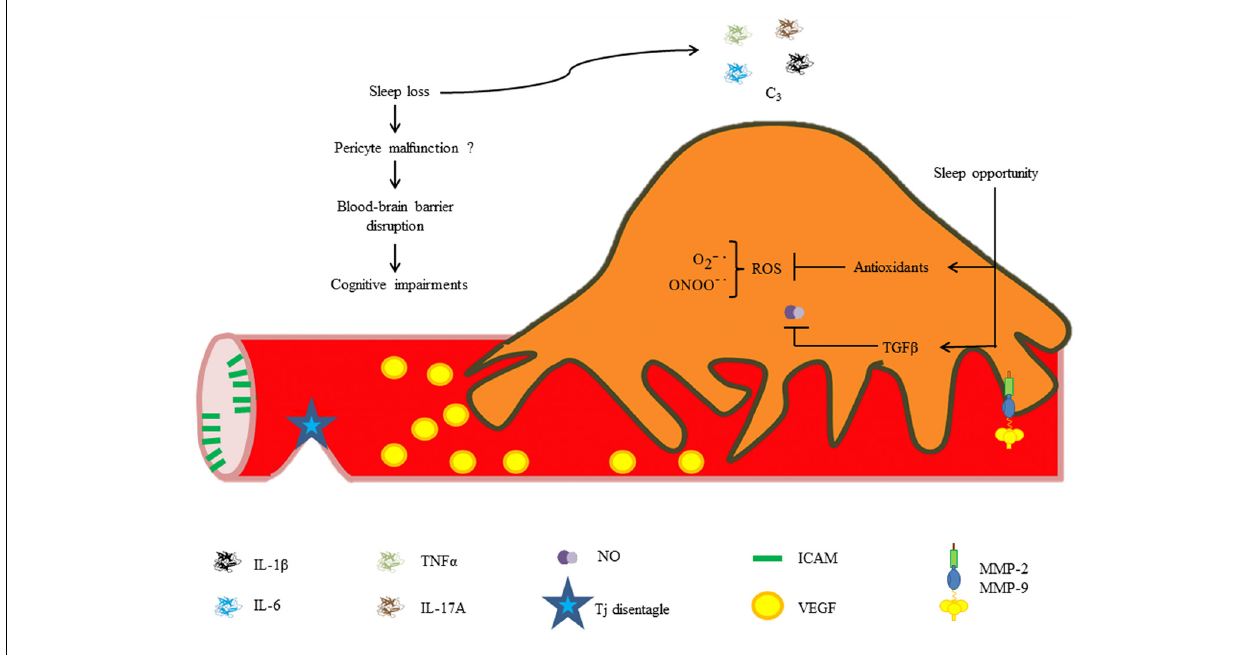
periods of sleep opportunity may reestablish the blood–brain barrier integrity through synthesis of antioxidants and anti-inflammatory cytokines (e.g., TGF- β